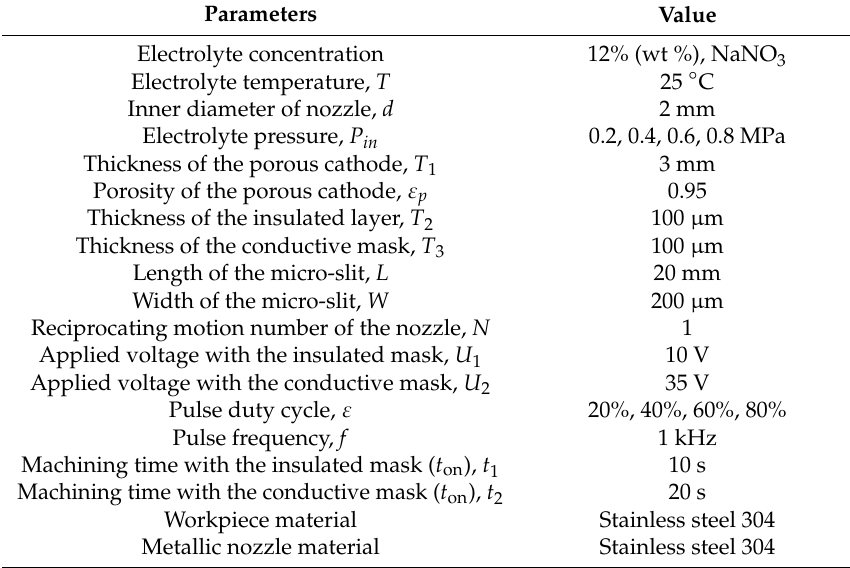
Figure 7. The image of conductive masked porous cathode. ( a ) Porous cathode; ( b ) Conductive mask. Table 2. Experimental machining parameters.